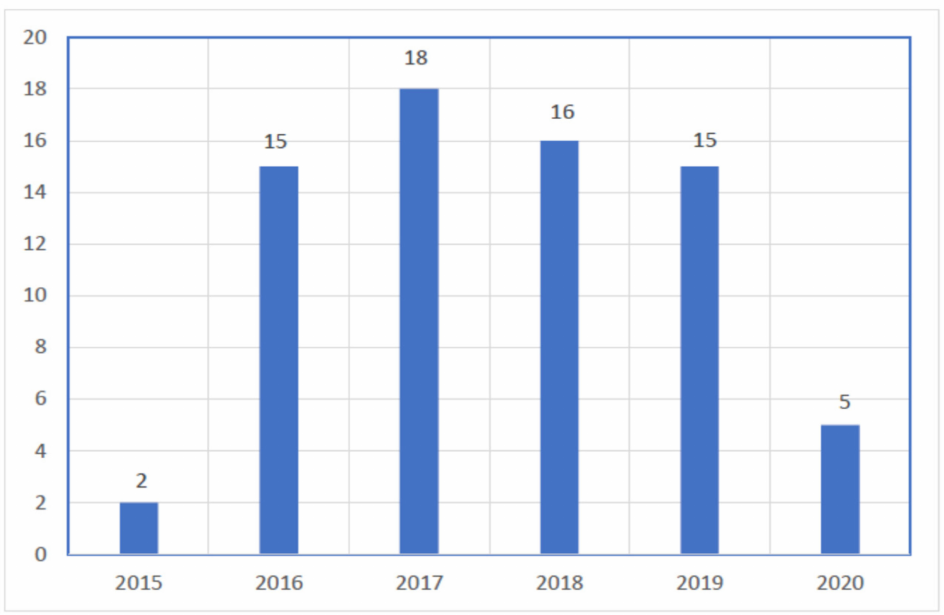
Figure 3. Studies selected per